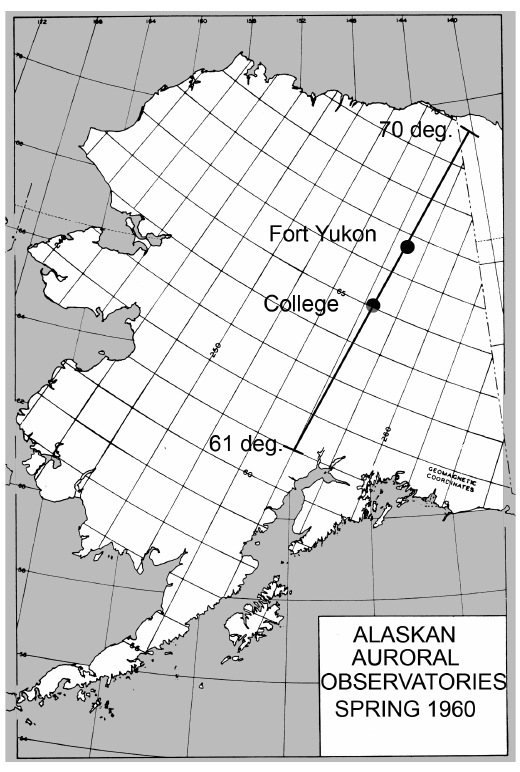
Fig. 2. Raw data from two simultaneous photometer scans from College and Fort Yukon (upper panel). The background brightness is removed by subtracting the dotted line from the data. The peaks in the remaining data are used to triangulate on the location of max- imum brightness (lower panel).